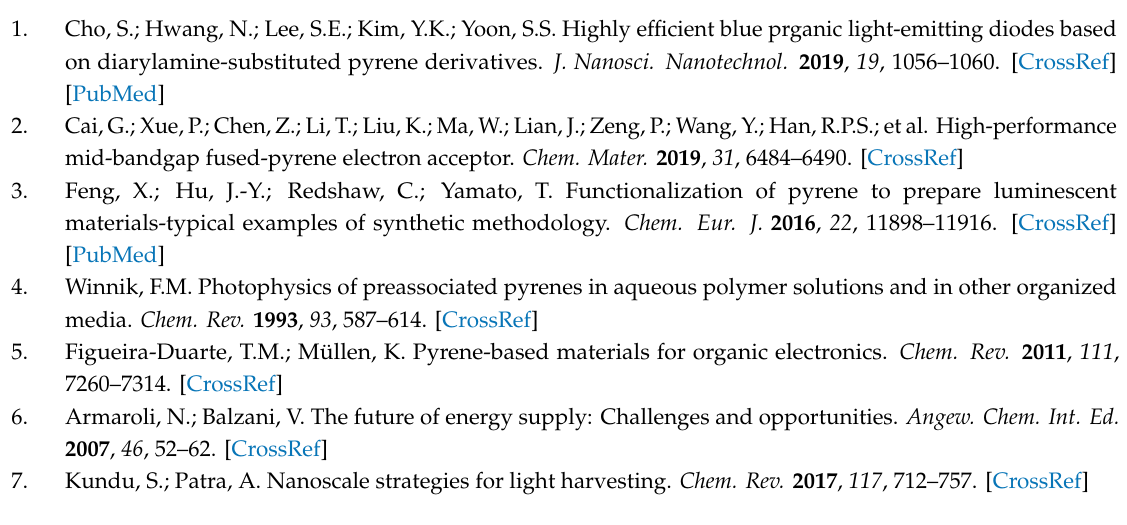
Synthetic procedures, Table S1: Composition of reaction mixtures during preparation of LPSQ / POSS-amide-Py; Figure S1: 29 Si NMR (CDCl 3 ) spectra of POSS-Cl and POSS-N 3 ; Figure S2: SEC analysis of LPSQ-N 3 ; Table S2: Molecular weight estimation based on SEC and NMR ( 1 H, 29 Si) analysis of LPSQ-Cl and LPSQ-N 3 ; Figure S3: 29 Si NMR (CDCl 3 ) spectra of LPSQ-Cl and LPSQ-N 3 ; Figure S4: Thermogravimetric analysis of POSS-triazole-Py and POSS-amide-Py; Figure S5: DSC analysis of POSS-amide-Py; Table S3: IR band position assignments; Figure S6: AFM and WAXS analysis of silane-triazole-Py; Figure S7: Reflected light microscopy images of LPSQ-amide50-Py and POSS-amide-Py; Figure S8: Absorption spectra of LPSQ, POSS and silane-triazole-Py solutions in CHCl 3 and THF; Figure S9: FL emission spectra of LPSQ and POSS-triazole-Py in CHCl 3 ; Figure S10: Absorption spectra of LPSQ and POSS-amide-Py; Figure S11: Emission and excitation fluorescence spectra of silane-triazole-Py and POSS-amide-Py; Figure S12: Energy transfer from POSS-triazole-Py to Nile Red and Coumarin 6; Figure S13: Energy transfer from LPSQ-amide50-Py and POSS-amide-Py to Coumarin 6; Figure S14: Changes in FL emission intensity of LPSQ and POSS materials in the presence of metal cations; Figure S15: Changes in FL emission intensity of POSS-triazole-Py and POSS-amide-Py in the presence of